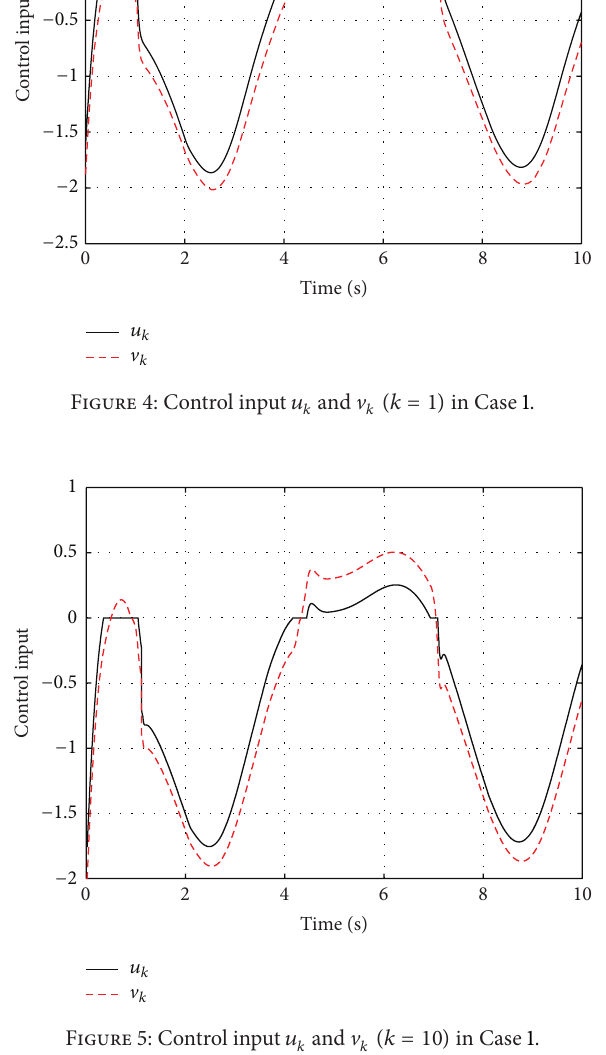
Figure 5: Control input 𝑢 𝑘 and V 𝑘 (𝑘 = 10) in Case 1.